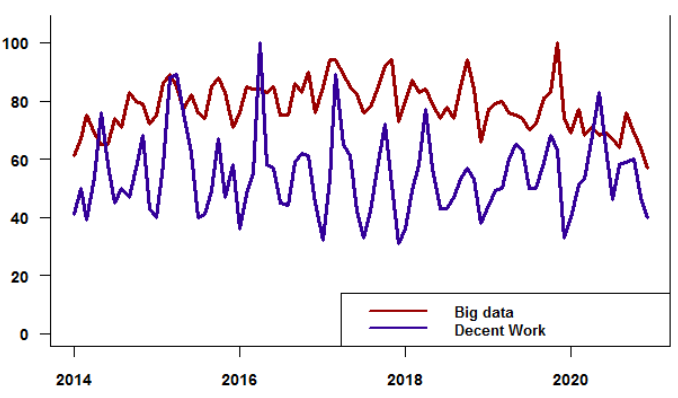
Figure 9. Big Data and SDG 8 global Google trends since